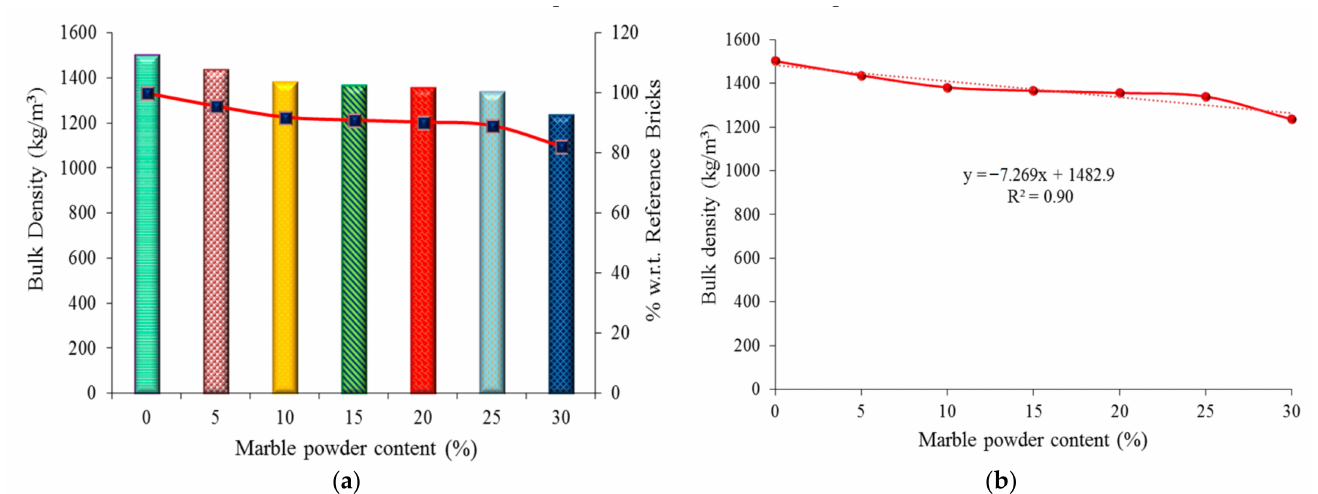
Figure 9. Graphical representation of bulk density: ( a ) experimental results, ( b ) empirical results.